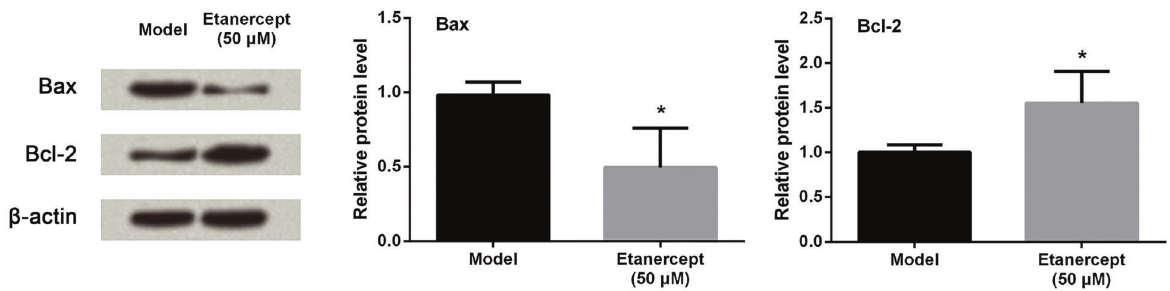
Figure 3. Protein levels of Bcl-2 and Bax in cardiomyocytes with endothelin-induced hypertrophy and then treated with 0 or 50 m M etanercept assessed by western blotting. Data are reported as means ± SD. *P o 0.05 compared with model (ANOVA).